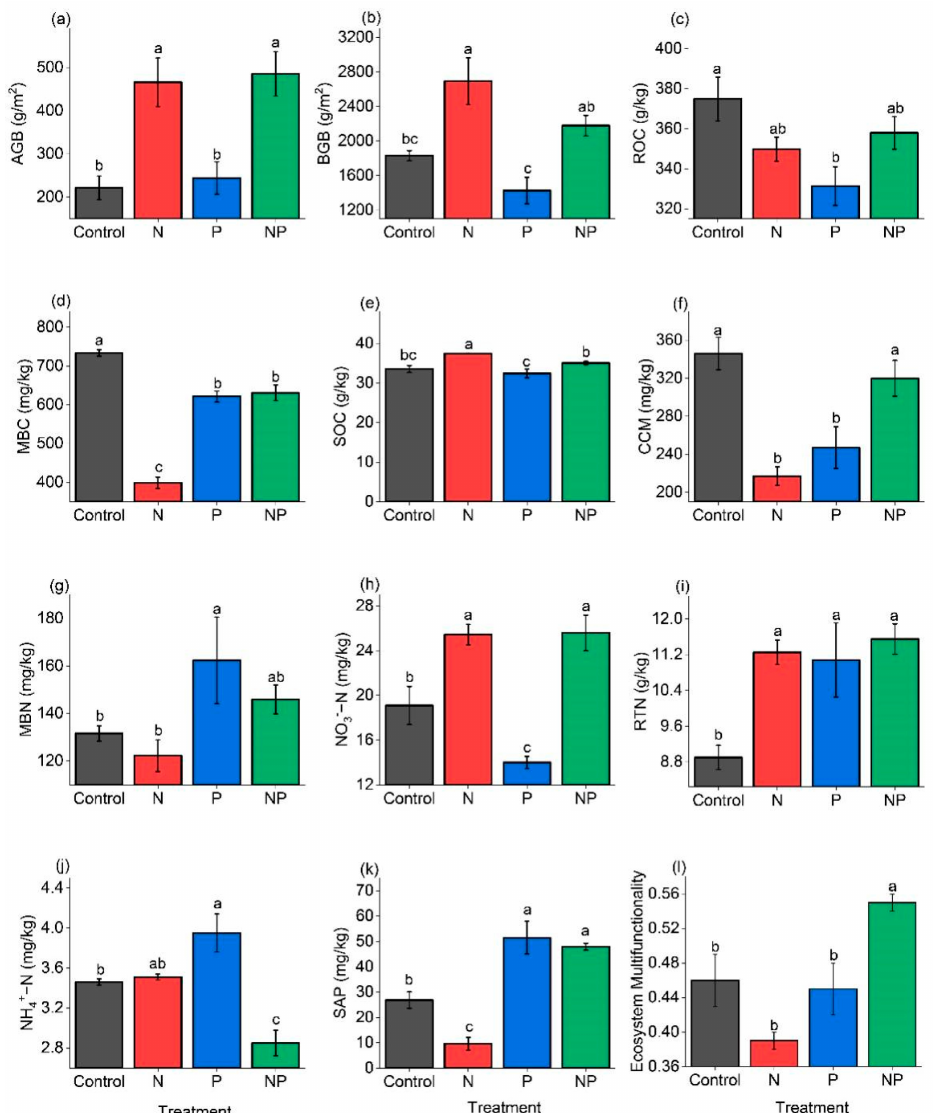
Figure 1. Effects of nitrogen and phosphorus addition on ecosystem parameters (M ± SE, n = 5), including ( a ) aboveground biomass (AGB); ( b ) belowground biomass (BGB); ( c ) roots organic carbon (ROC); ( d ) microbial biomass carbon (MBC); ( e ) soil organic carbon (SOC); ( f ) cumulative carbon mineralization (CCM); ( g ) microbial biomass nitrogen (MBN); ( h ) soil nitrate nitrogen (NO 3 − − N); ( i ) roots total nitrogen (RTN); ( j ) soil ammonia nitrogen (NH 4+ − N); ( k ) soil available phosphorus (SAP); ( l ) ecosystem multifunctionality (EMF). Different letters indicate that the same index has significant differences between different treatments ( p < 0.05). Abbreviations: Control, the control without any nutrient addition; N, N-alone addition; P, P-alone addition; NP, N and P together